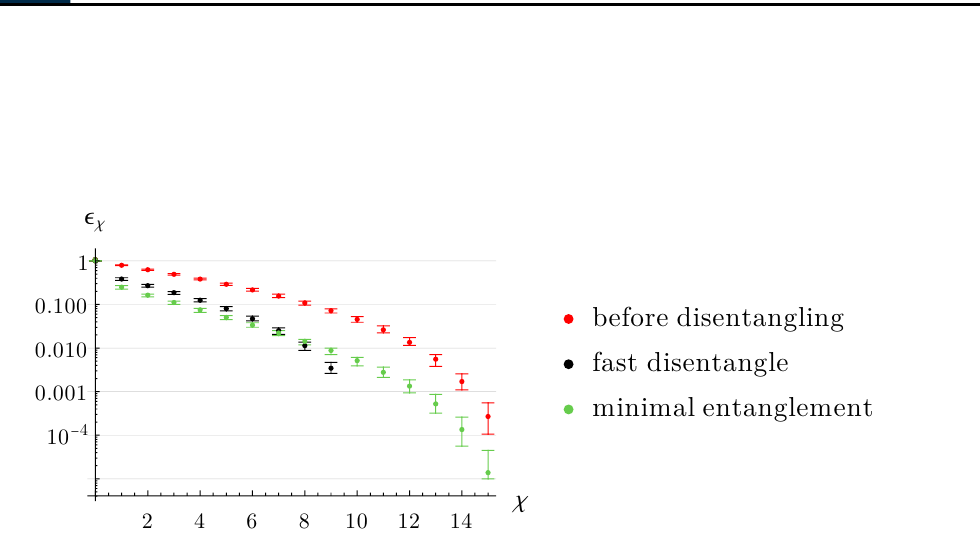
Figure 2: The truncation error [ Eq. (11) ] to bond dimension χ where U · A has di- mensions 4 × 4 × 4 × 4 and the tensor A is Gaussian random. Similar to Tab. 1, we also show the two-sided deviations to the 16 th and 84 th quantiles. We see that our fast algorithm outperforms the minimal entanglement disentangler for χ ≥ 8 and has zero truncation error for χ ≥ 10, which is consistent with the 6 zero singular values predicted by Eq. (9).